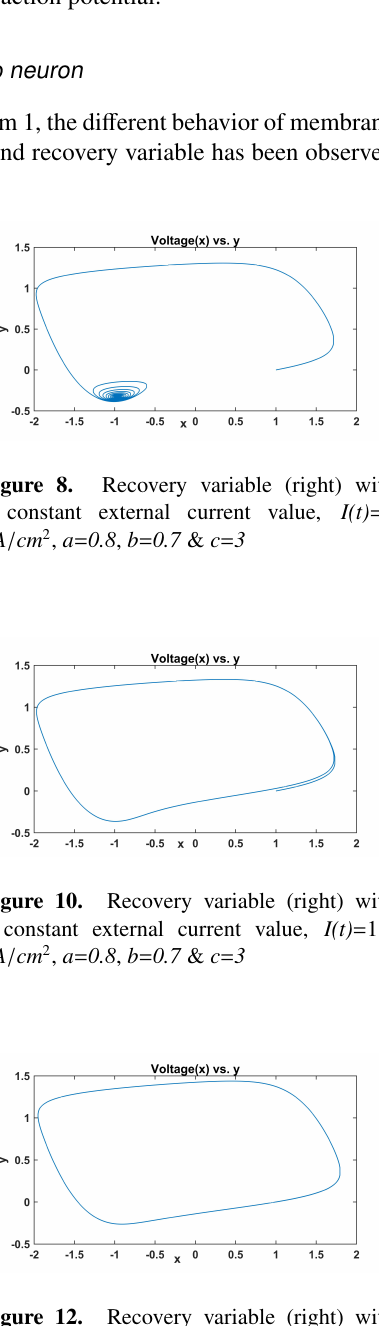
Figure 12. Recovery variable (right) with a constant external current value, I(t) = 1.5 µ A / cm 2 , a = 0.8 , b = 0.7 & c = 3